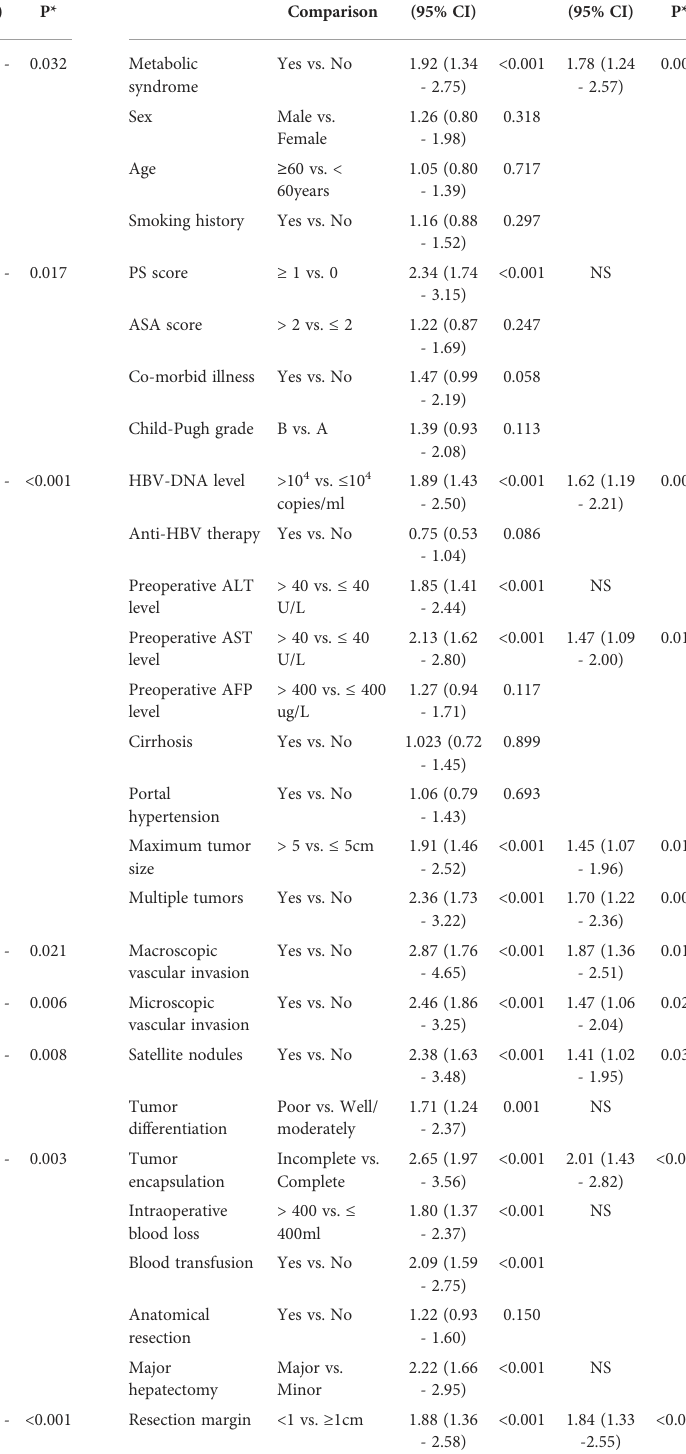
TABLE 3 Univariable and multivariable Cox regression analyses on risk factors of overall survival.